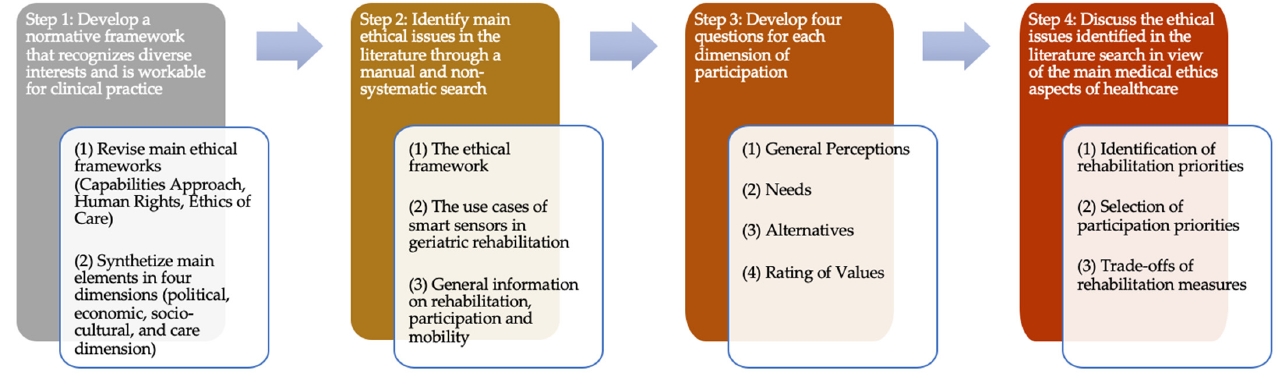
Figure 1. The 4 Steps to align patient’s ideas of a good life with medically indicated therapies.